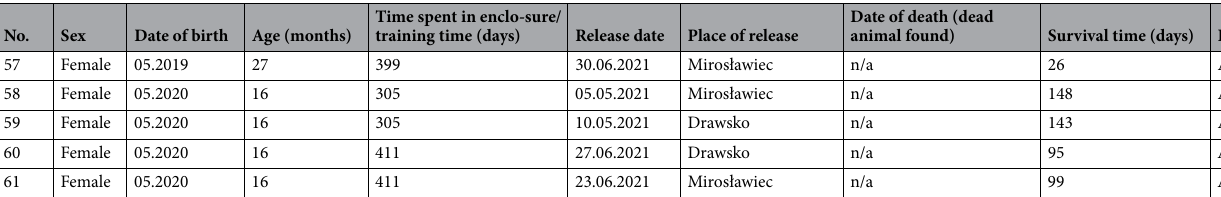
Table 1. Characteristics of Eurasian lynx reintroduced in north-western Poland in January 2019–July 2021 (age—as of 30 September 2021 for live animals; survival time—number of days from release until death was confirmed or until 30 September 2021 for live animals; fate (status as of 30 September 2021): C—caught and placed in an enclosure, A—alive, L—a female that had a litter, D—dead, with cause of death marked in parentheses as unknown (U), environmental factors/scabies (S) or road collision (C), U—status unknown; n/a—not applicable; the animals caught soon after release and placed in the breeding centre are marked in bold; the animals caught soon after release and re-released in another location are marked in italics).